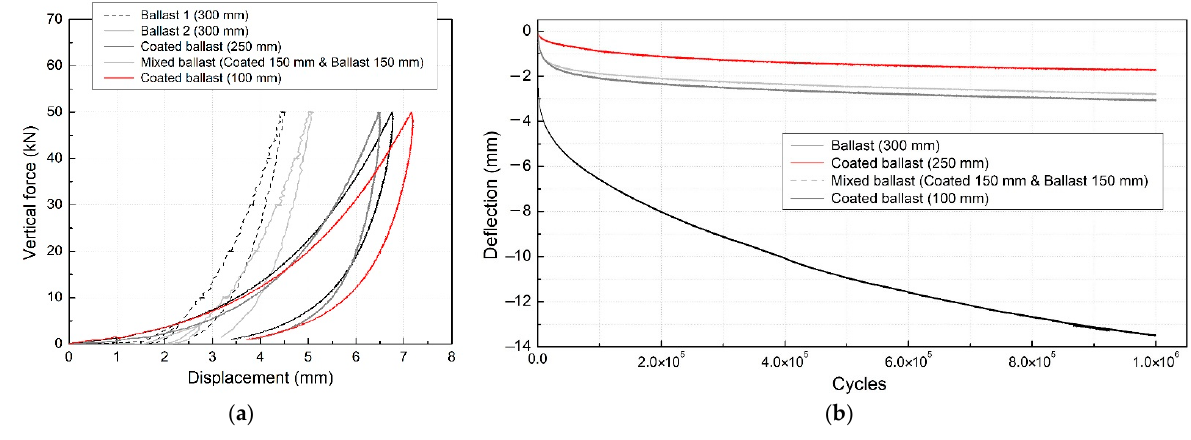
Figure 6. Overview of laboratory experiment results: ( a ) Load–displacement curve according to test conditions. ( b ) Settlement curve according to number of cycles.